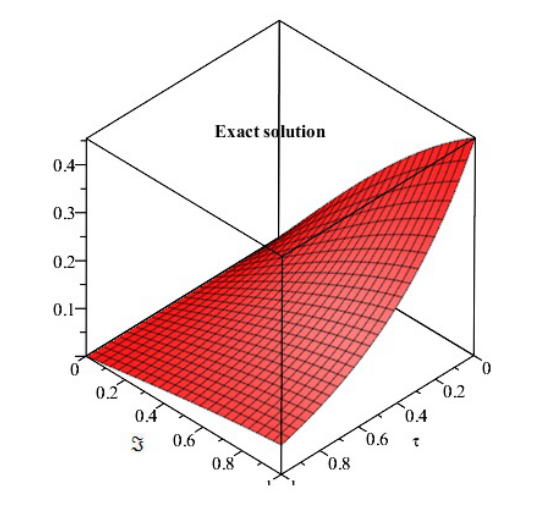
Figure 5. Represents the exact solution of Example 2 at β = 1.